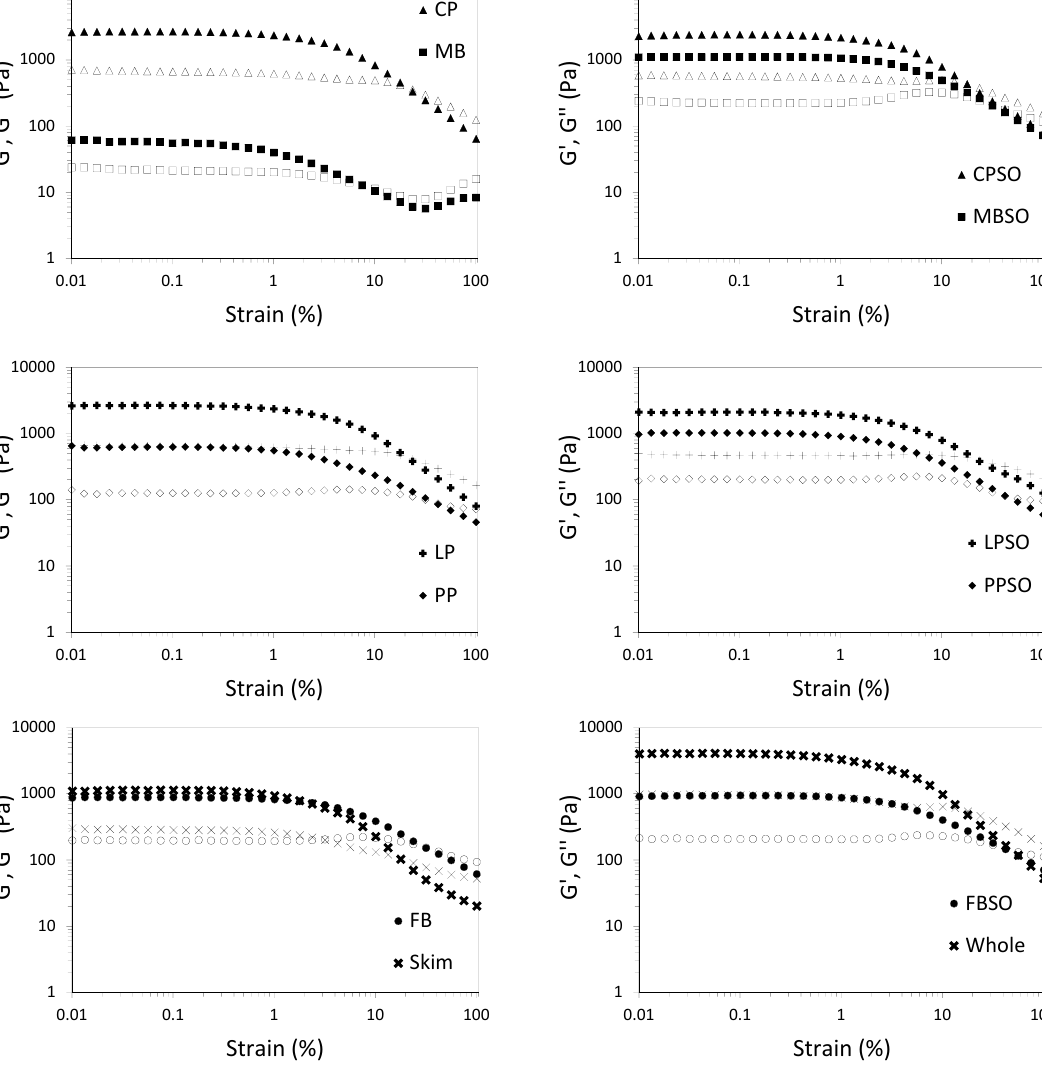
Figure 1. Amplitude sweeps of high pressure-treated 12% ( w / w ) mung bean (MB), chickpea (CP), pea (PP), lentil (LP) and faba bean (FB) protein samples without and with 5% ( w / w ) sunflower oil (SO) as compared to commercial plain skim and whole milk Greek yogurt. Storage modulus, G’ (closed symbol) and loss modulus, G” (open symbol). Each curve is the average of two treatments.